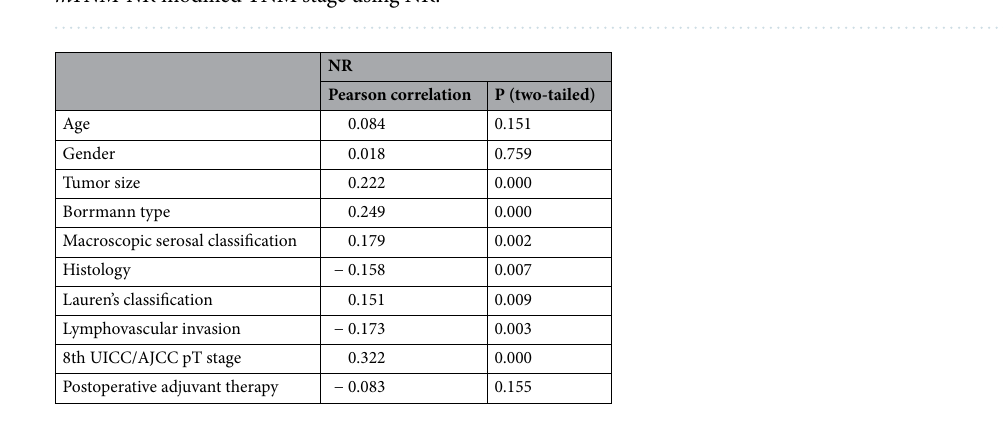
Table 4. Correlation between NR and other clinicopathologic parameters. *Correlation is significant at the 0.01 level (2-tailed).